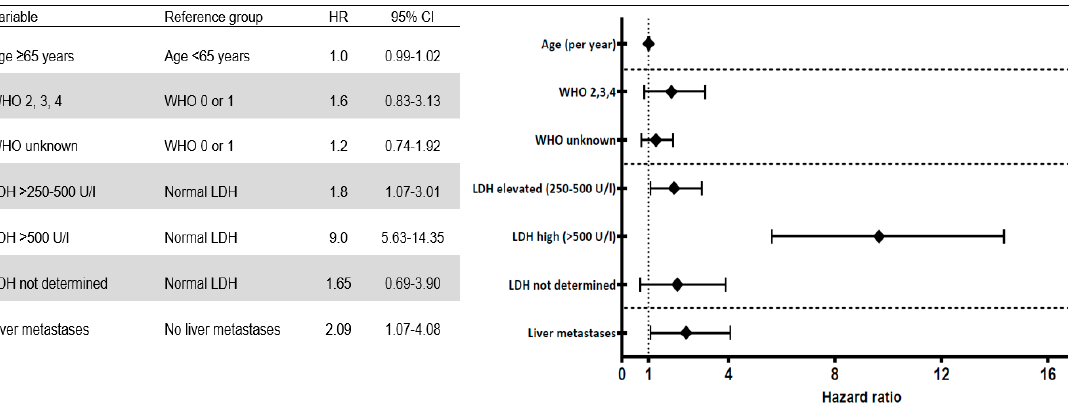
Figure 7. Multivariable hazard ratios (HR) associated with poorer survival in the full cohort along with the 95% confidence interval (CI).